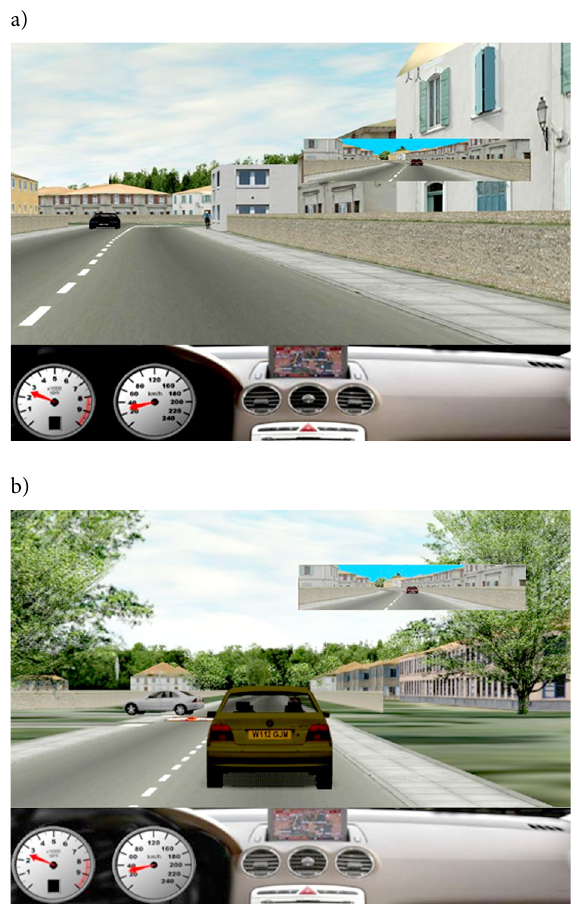
Fig. 5. Driver’s front view in the